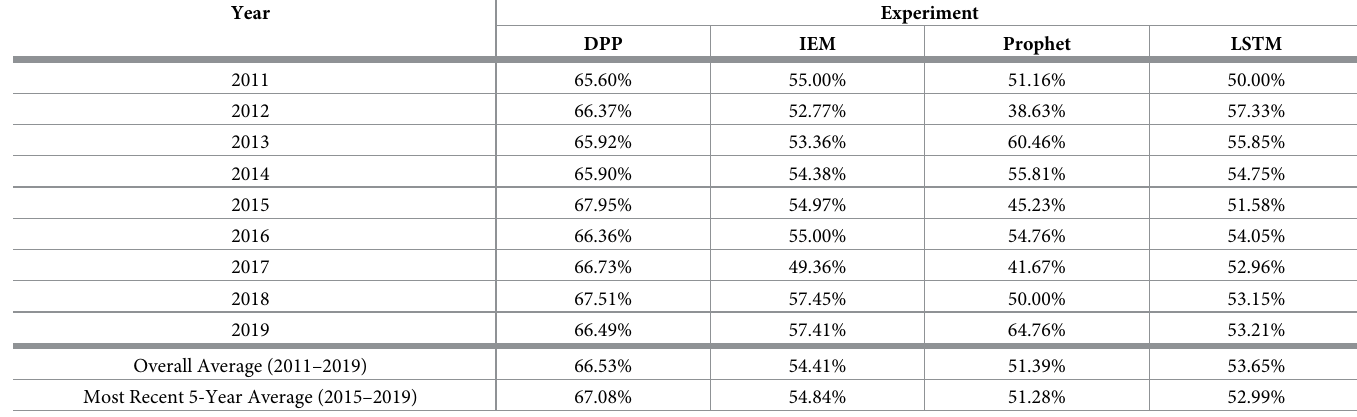
Table 2. Accuracy comparison for each year (NI225